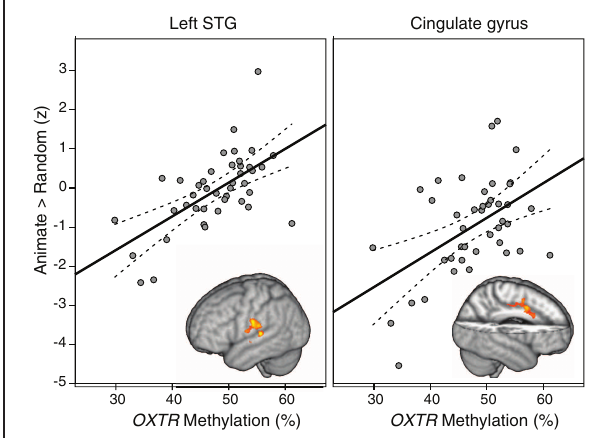
FIGURE 1 | Regions demonstrating a significant association between OXTR methylation and Animate > Random activity. Clusters from whole-brain analysis are depicted in MNI space and neurological orientation. Average z -statistic values from the contrast of parameter estimates (COPE) in the left STG and dACC are plotted against percent OXTR methylation for each participant, with dashed lines indicating 95% confidence interval (CI) around fit